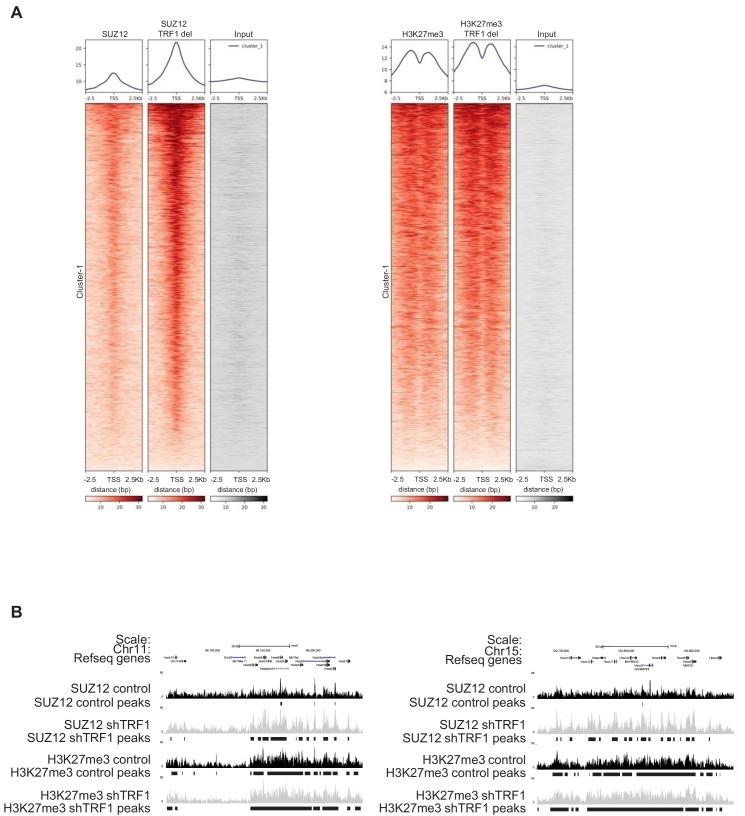
Abrogation of TRF1 in 2i-grown iPS cells induces the loss of the naïve state and a transition to a primed or differentiated state.(A) Heatmaps of the reads of SUZ12 and H3K27me3 around 2.5 Kb of the transcriptional start sequence (TSS) of bivalent genes. Note the dramatic increase of SUZ12 deposition at the TSS of bivalent genes. Increase in H3K27me3 at these sites was also clear but moderate. (B) Gain of SUZ12 and H3K27me3 peaks in some Hox clusters.